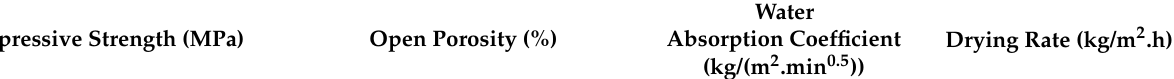
Table A1. Experimental results of each sample/measurement for each